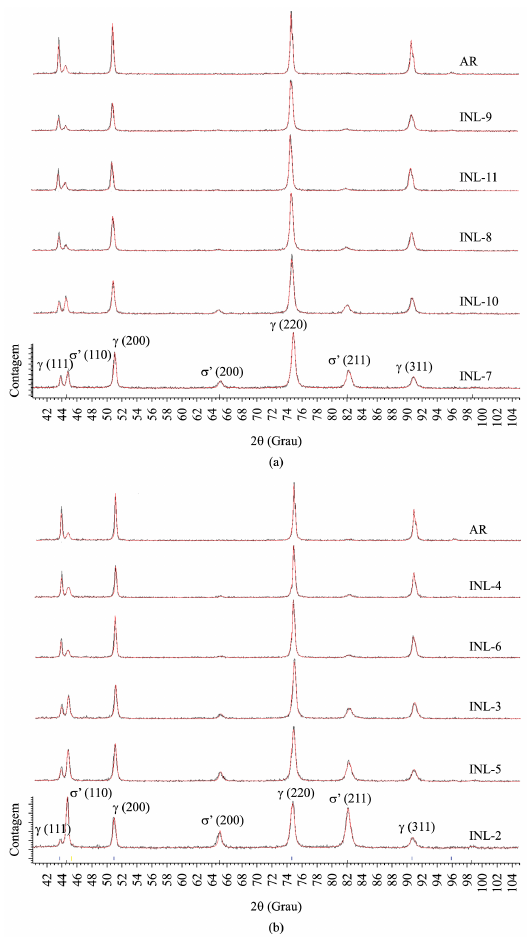
Figure 1. Evolution of martensitic transformation in different stop conditions with strain rates (a) 5.55×10 -3 e (b) 5.55×10 -4 s -1 . Samples with Element (weight, %)